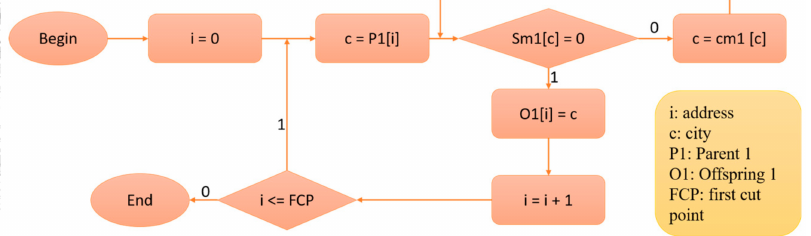
Figure 4. Filling of the “O ff spring 1” before the first cut point in